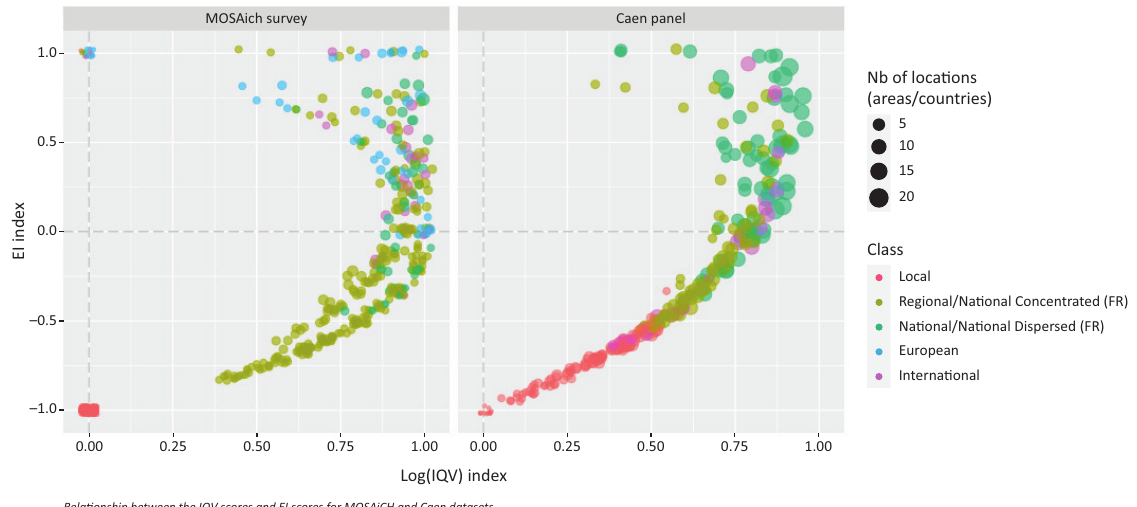
Figure 2. EI scores by IQV scores for the MOSAiCH survey and the Caen Panel. Note: Because many points overlapped each other for the small networks of the MOSAiCH sample, we added a small amount of random noise to each point to better identify where the mass of the data